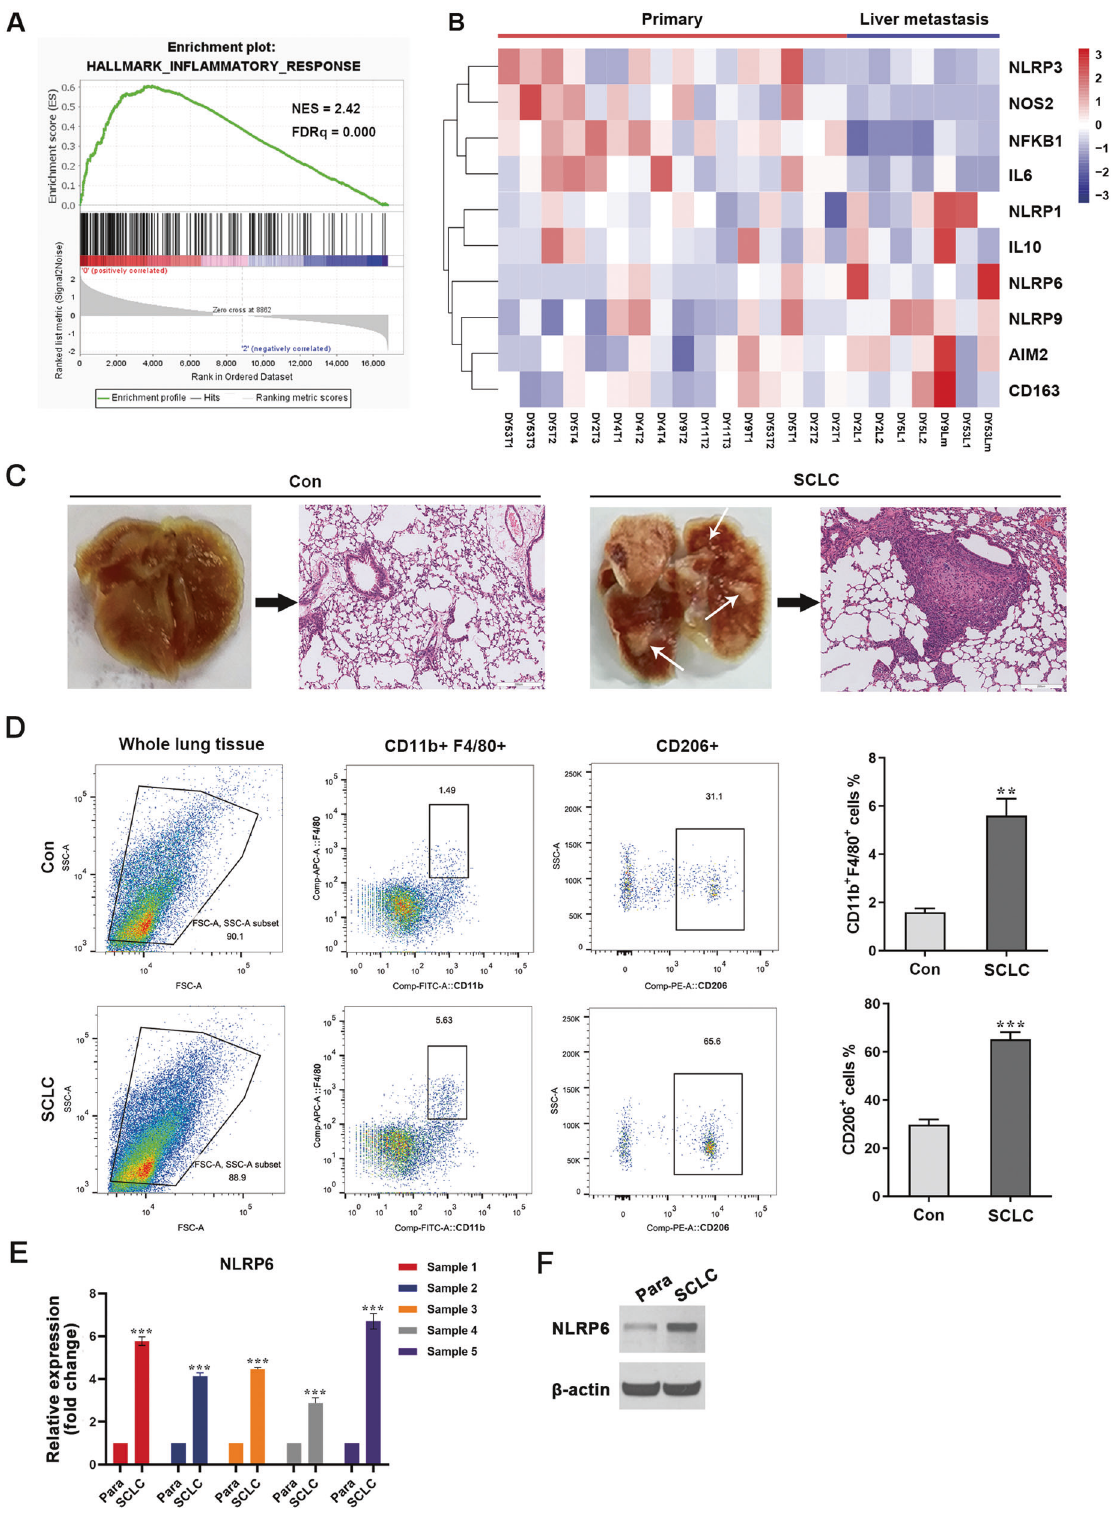
Fig. 3 M2 TAMs in fi ltrate into pulmonary SCLC site. A GSEA plots showing the enrichment of the in fl ammatory response pathway in the primary site. B A heatmap showing expression levels of genes associated with the in fl ammatory response in primary tumors versus liver metastasis. C Lungs were excised from tumor-bearing mice and pulmonary SCLC tumors were isolated. Gross specimens and H&E-stained images of lungs are shown. White arrows point to the SCLC site. Con, untreated control mice. SCLC, mice injected with SCLC cells through tail vein. D Flow cytometry analysis of the polarization state of in fi ltrated macrophages in the lung tumor site of the SCLC nude mouse allograft model ( n = 5). E qRT-PCR analysis of NLRP6 expression in lung tumor site from the SCLC nude mouse allograft model ( n = 5). F Immunoblot analysis of NLRP6 expression in lung tumor site from the SCLC nude mouse allograft model ( n = 5). Para, para-cancerous tissue. SCLC, SCLC cancerous tissue. Bar graphs show the mean±SEM; ** P <0.01, *** P <0.001. TAMs tumor-associated macrophages, SCLC small cell lung cancer, GSEA gene set enrichment analysis, H&E hematoxylin and eosin, SEM standard error of mean. Cell Death and Disease (2022)